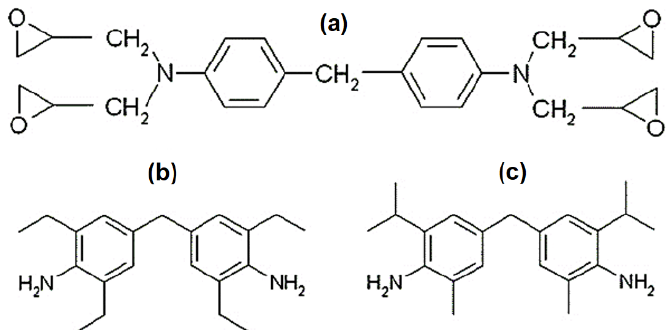
Figure 1. Chemical structure of ( a ) tetraglycidyl methylene dianiline, ( b ) 4,4 ′‐ methylenebis(2,6 ‐ diethylaniline), and ( c ) 4,4 ′‐ methylenebis(2 ‐ isopropyl ‐ 6 ‐ methylaniline) [16]. The 4,4 ‐ bis(p ‐ hydroxyphenyl)pentanoic acid (diphenolic acid), tin(II) 2 ‐ ethylhexanoate (92.5– 100%), Sn(Oct) 2 , and tetrahydrofuran (99.9%, THF) were purchased by Sigma ‐ Aldrich and used as received.